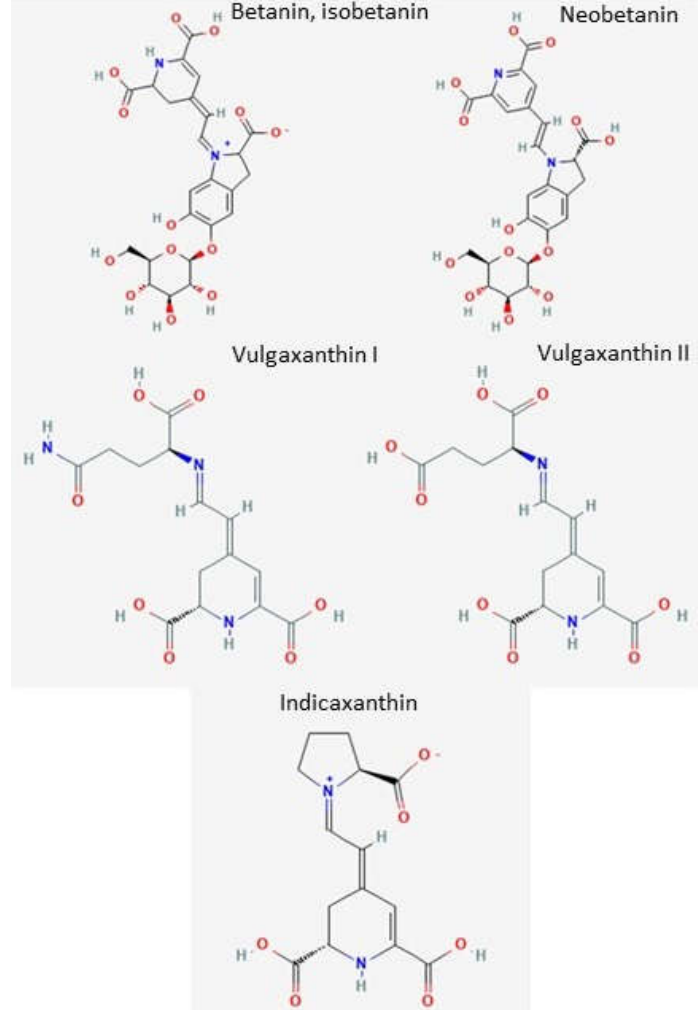
Figure 1. Betalain pigments in beetroots (structural formula).